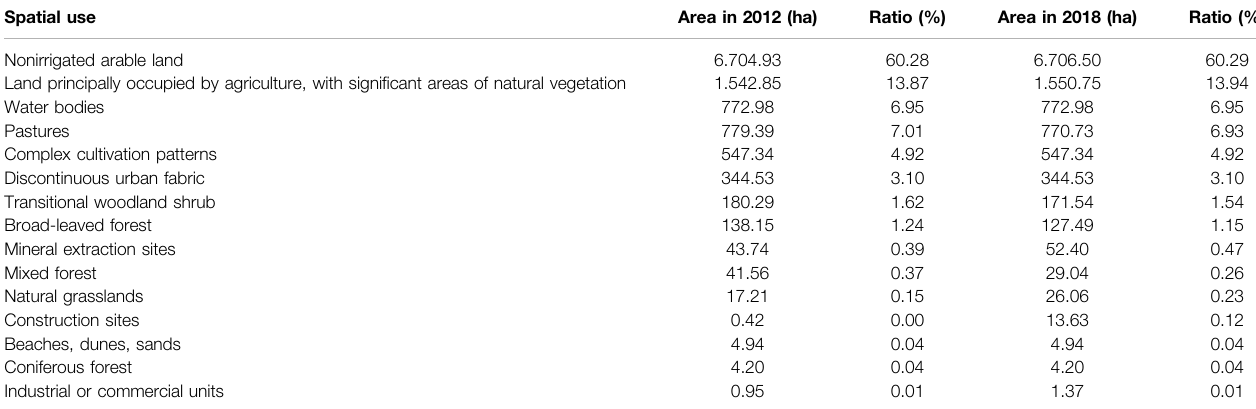
TABLE 4 | Spatial uses in the plan area in 2012 and 2018. Spatial